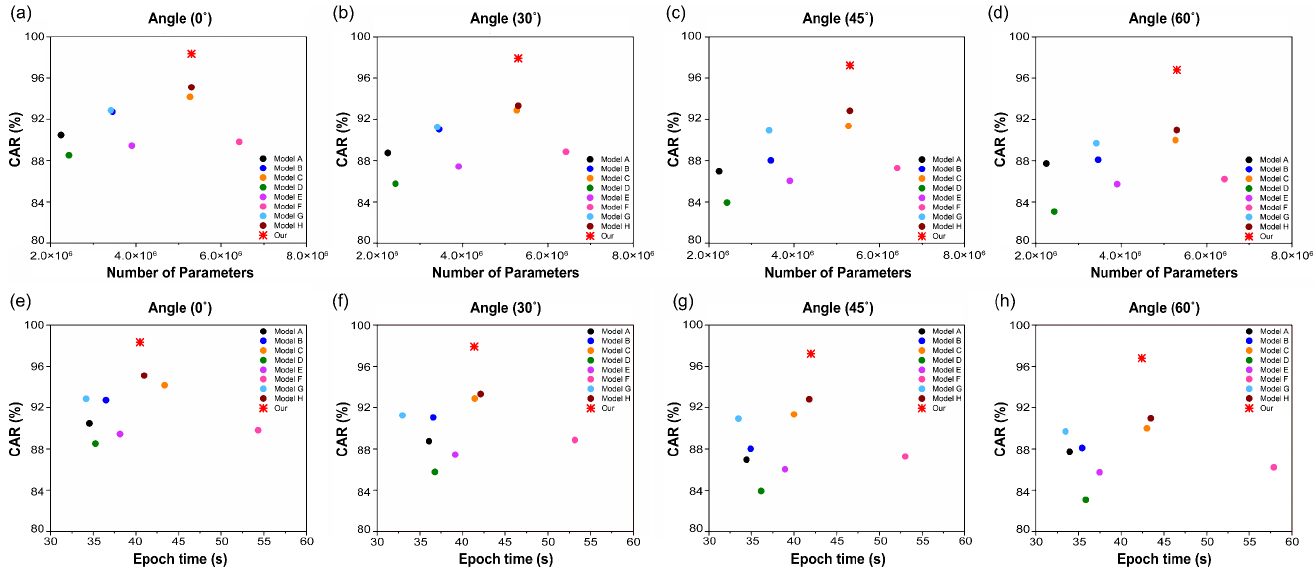
Figure 11. Comparison of character accuracy rate (CAR) between the proposed model and other models according to the ( a – d ) number of parameters and ( e – h ) average epoch time. Table 4. Comparison between the number of parameters and epoch times of the proposed method and different methods.